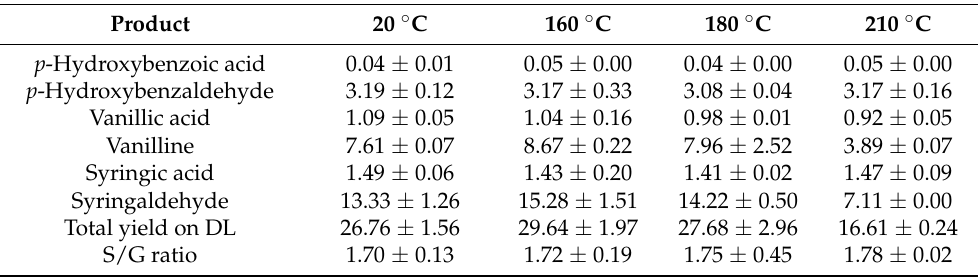
Table 3. Phenolic aldehydes and acids from nitrobenzene oxidation of padauk dioxane lignins (mean ± SD, %).